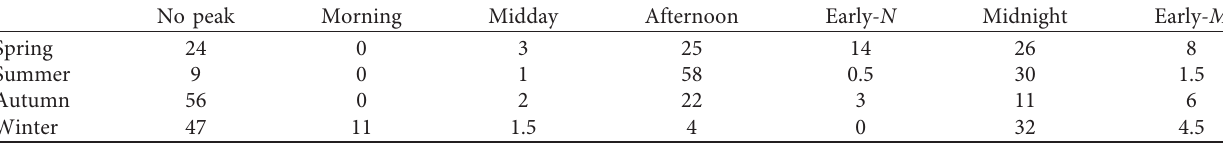
Table 3: The percent of different types of diurnal variation in Figure 4 (unit: %).